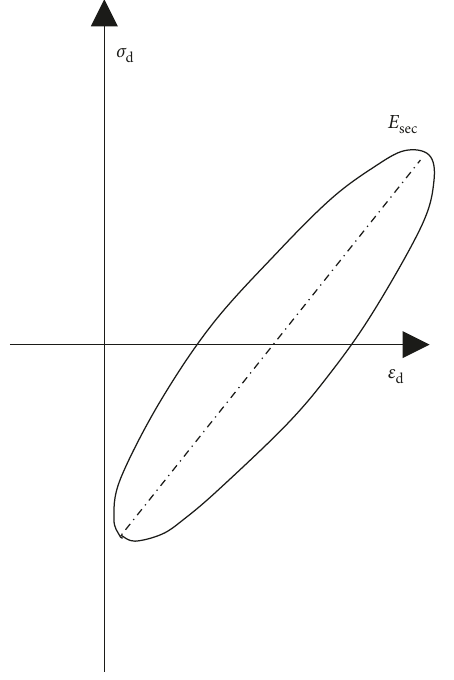
Figure 7: Dynamic secant elastic modulus E